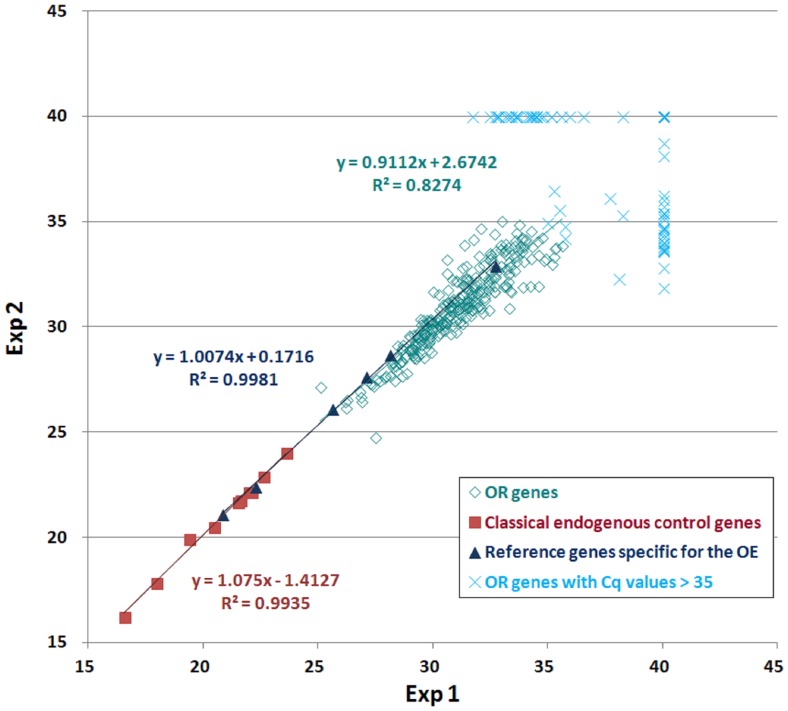
Inter-run calibration analysis.Plotted expression pattern correlation for all detected targets (Cq average below 35) from the same RNA WHOM sample in two different runs. OR genes (green ◊), reference genes specific for the olfactory epithelium (blue Δ) and classical endogenous control genes (red ▪). Cq values above 35 are not reproducible (turquoise x). R2 is the coefficient of correlation.